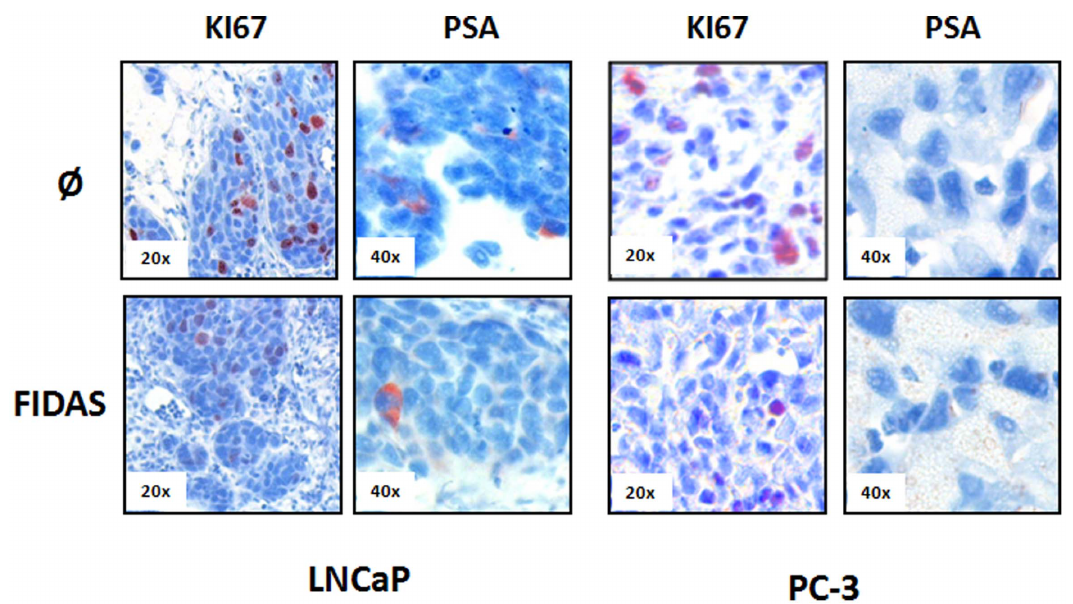
Figure 6. Effects FIDAS on prostate cancer micro-tumors growing on the CAM. CAM assays were performed with PC-3 (AR negative) and LNCaP (AR-positive) as described in Material and Methods. Proliferation of PC cells was determined by nuclear staining of KI67. AR-activity was analyzed by PSA-staining.